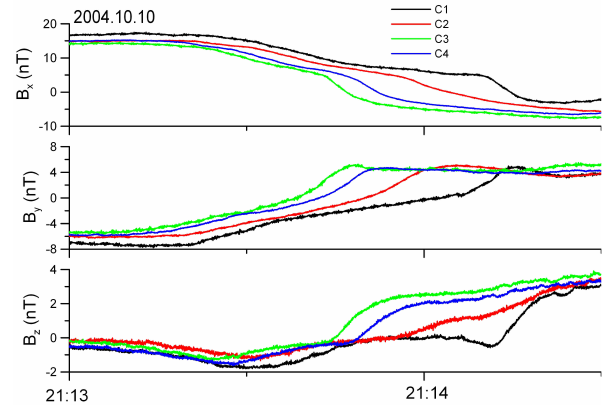
Fig. 8. Magnetic field components for the case 10 October 2004 (#21).